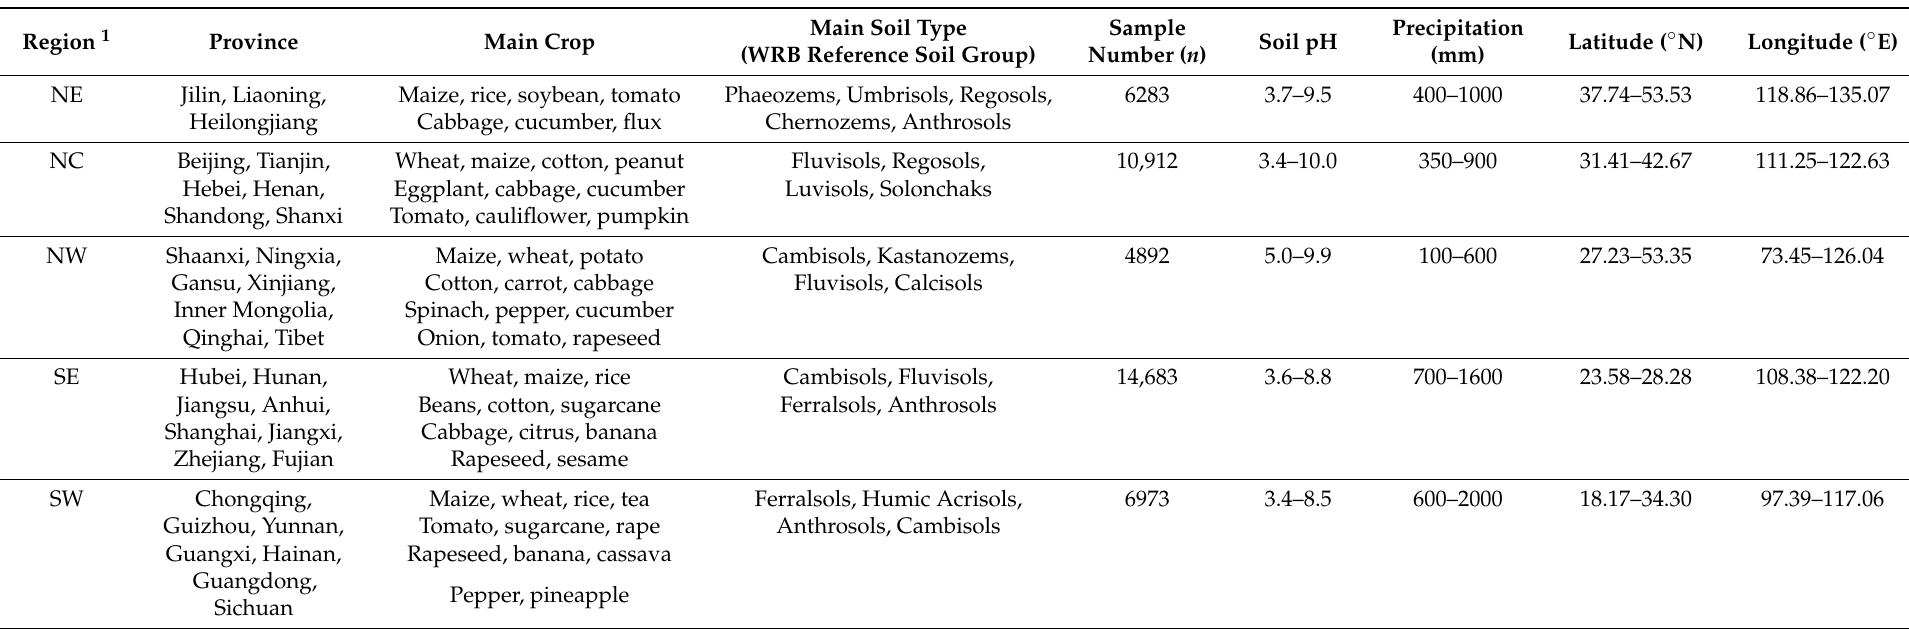
Table 2. Summary of experimental sites from 1991 to 2012 for different geographical regions in China’s